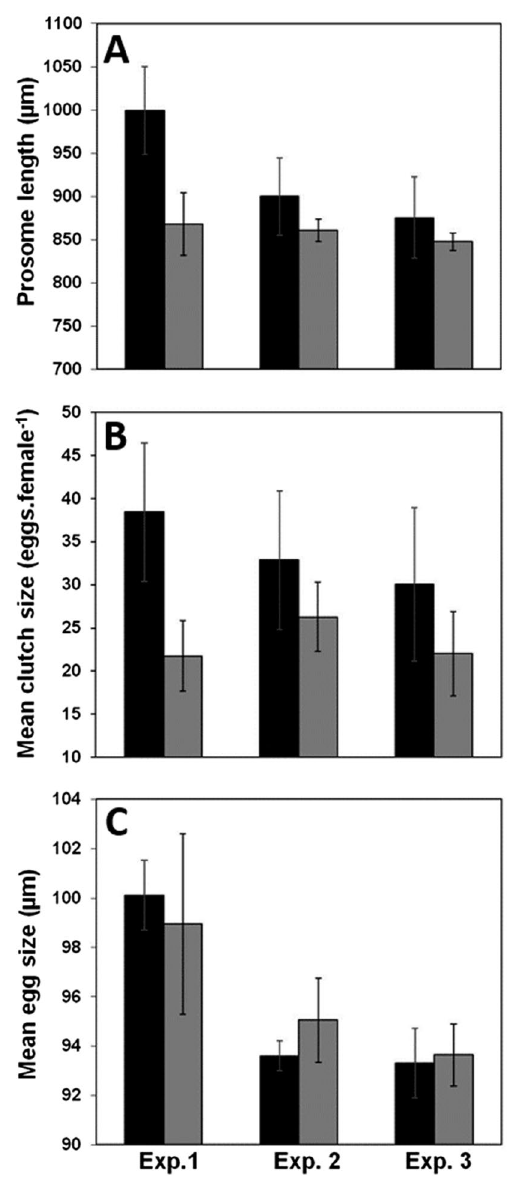
Figure 2. Each bar represents the mean of generations under different conditions. Exp. 1: experiment conducted under T07S15 then T24S15(T07); Exp.2: experiment conducted under T20S15 then T24S15; Exp.3: experiment conducted under T20S25 then T24S25, Black bars: initial conditions, grey bars: final conditions (transfer to 24